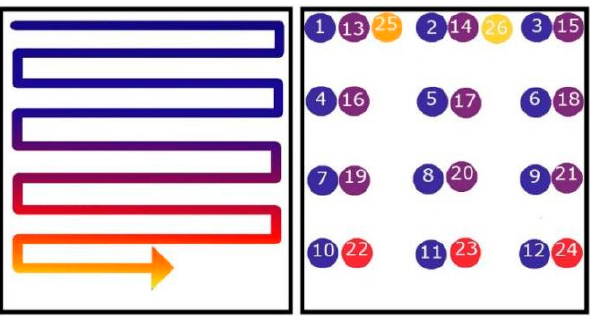
Figure 12. Line scan and point scan schematics [52].